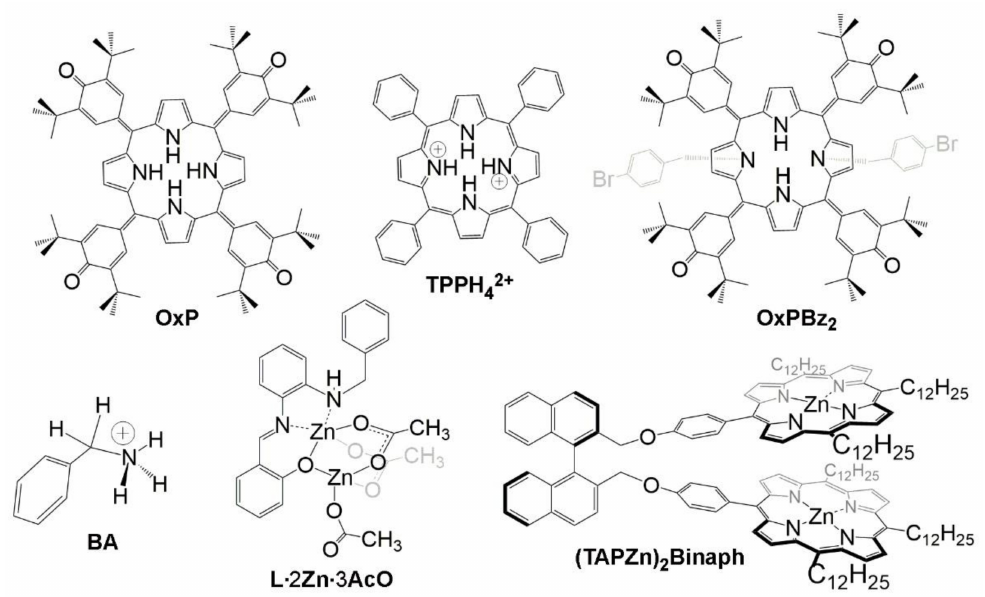
Figure 1. Chemical structures of the probe molecules: 5,10,15,20- tetrakis (3,5-di- t -butyl-4-oxocyclohexa- 2,5-dienylidene)porphyrinogen ( OxP ); 5,10,15,20-tetraphenylporphyrin dication ( TPPH 42+ ); N 21 N 23 - bis(4-bromobenzyl)-5,10,15,20- tetrakis (3,5-di- t -butyl-4-oxocyclohexa-2,5-dienylidene)porphyrinogen ( OxPBz 2 ); benzylammonium ( BA ); salen-Zn 2 acetate bridged dimer ( L · 2 Zn · 3 AcO ); 1,1 (cid:48) -binaphthyl trialkylporphyrinatozinx (II) cofacial dimer ( (TAPZn) 2 Binaph